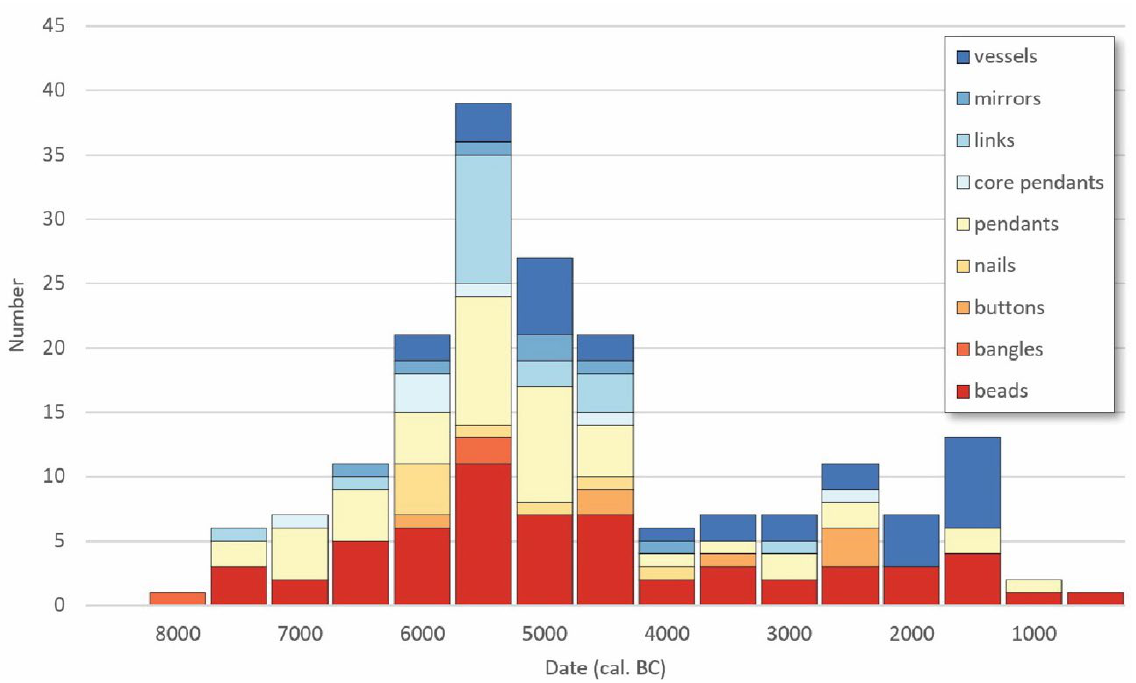
Figure 10. Schematic diagram summarising the occurrence of different types over time. The data on which this is based may be found in Supplementary files 1 and